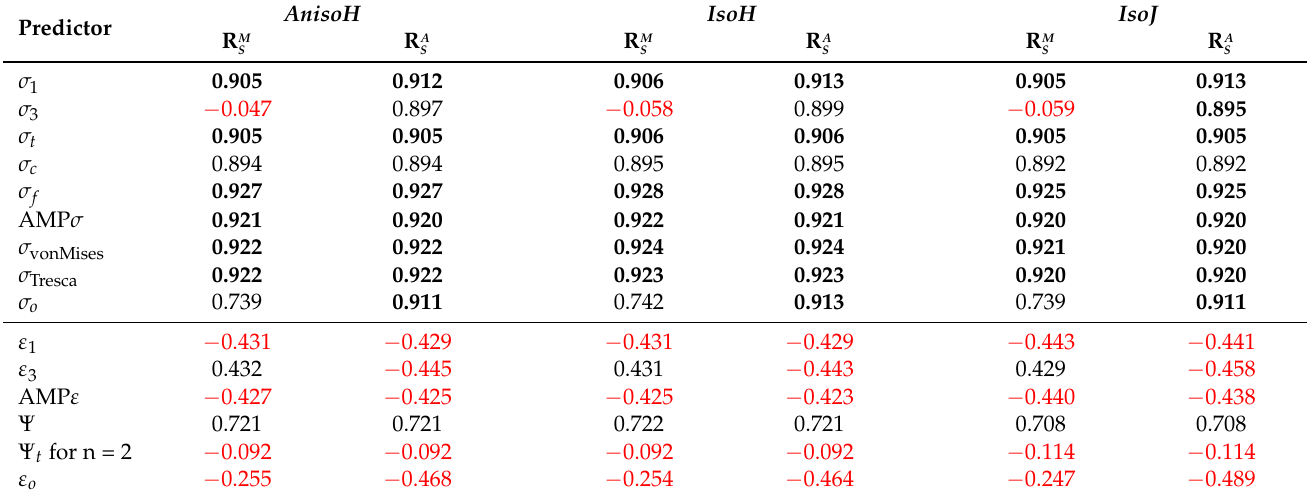
Table 3. Weighted Spearman correlation coefficients obtained for GLT = 80, constitutive models AnisoH , IsoH and IsoJ and using C3D4 elements: for the maximum variable throughout the cycle, R M , and for the amplitude throughout the cycle, R A . The predictors analysed are: the maximum S S principal stress ( σ 1 ), the minimum principal stress ( σ 3 ), the absolute maximum principal stress (AMP σ ), the corresponding strains ( ε 1 , ε 3 and AMP ε ), the strain energy density (SED or mechanical stimulus at the continuum level Ψ ), the mechanical stimulus at the tissue level ( Ψ t ), the maximum tensile and compressive stresses ( σ t and σ c , respectively), the fluctuation of stresses ( σ f ), the von Mises and Tresca stresses, the hydrostatic stress ( σ o ) and the volumetric strain ( ε o ). Values higher than 0.9 are highlighted in boldface; negative values are in